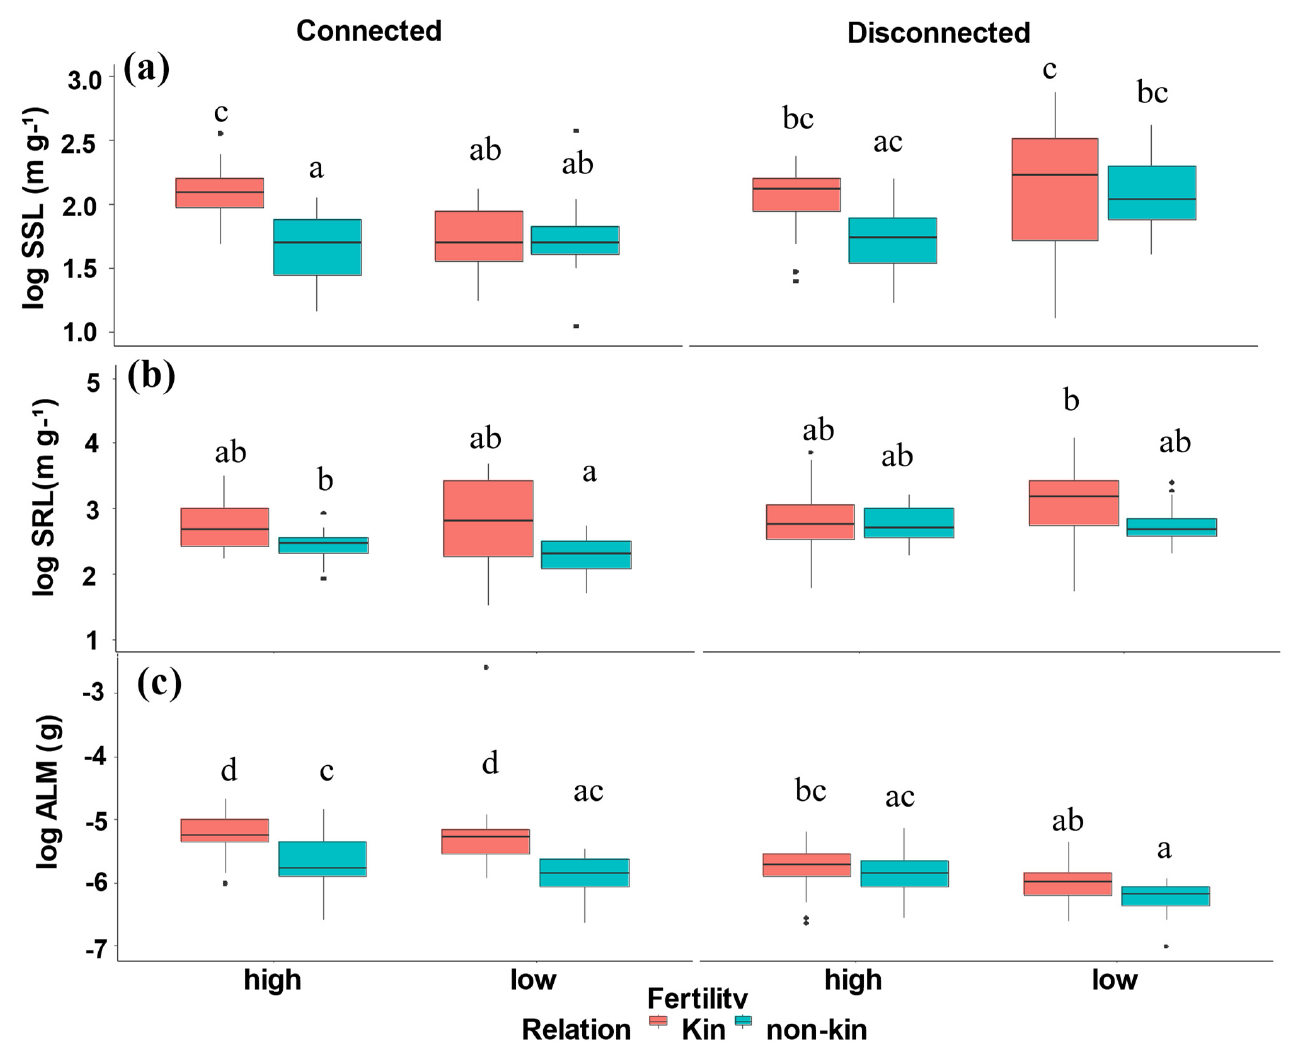
Figure 3. ( a ) Specific stem length (SSL), ( b ) Specific root length (SRL), and ( c ) Average leaf mass (ALM) of kin and non-kin in all treatment combinations including low- versus high-nutrient connected and low- versus high-nutrient disconnected treatment. Common letters within each panel indicate no statistically significant difference among the treatment pairs in that panel (based on Tukey HSD tests).